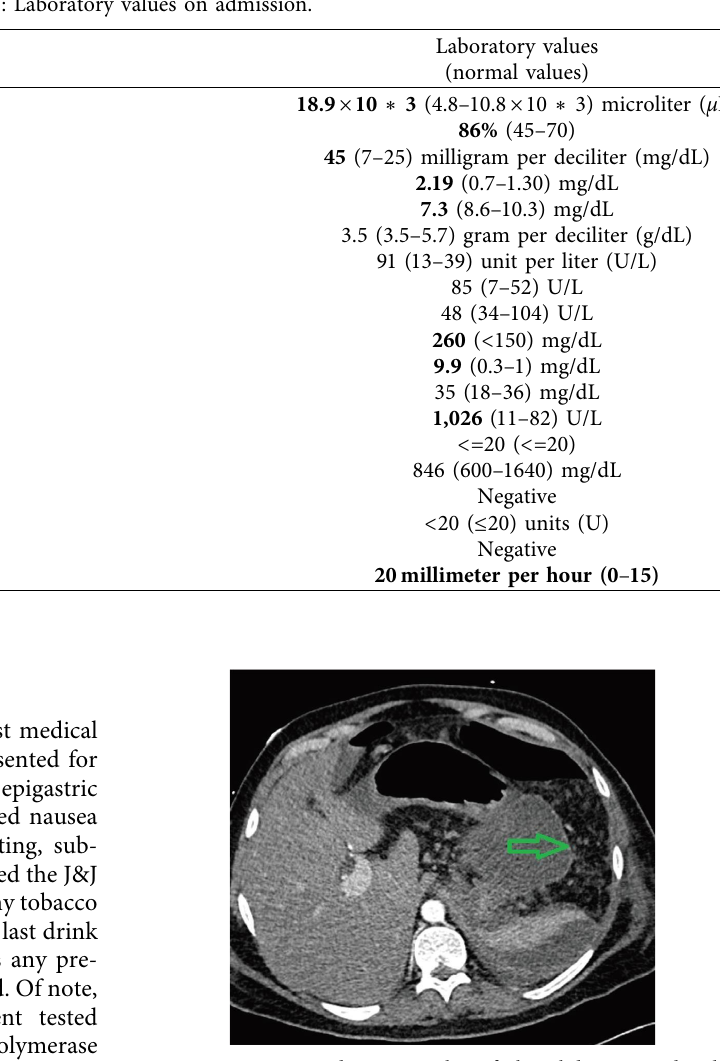
Table 1: Laboratory values on admission.